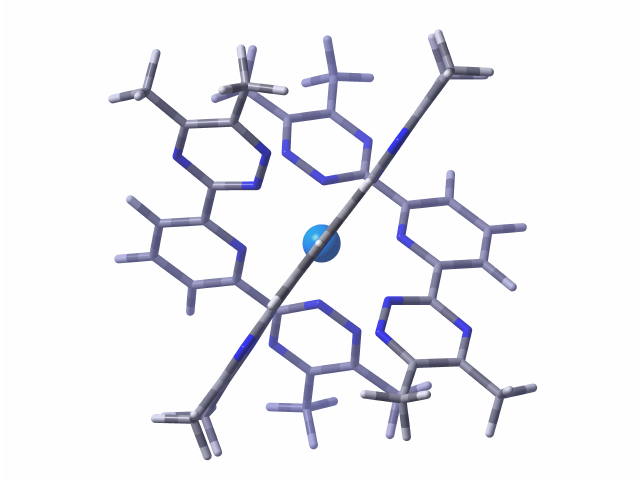
Figure 4. Stereochemistry of U(MeBTP) 3 + approximate 3-fold rotational